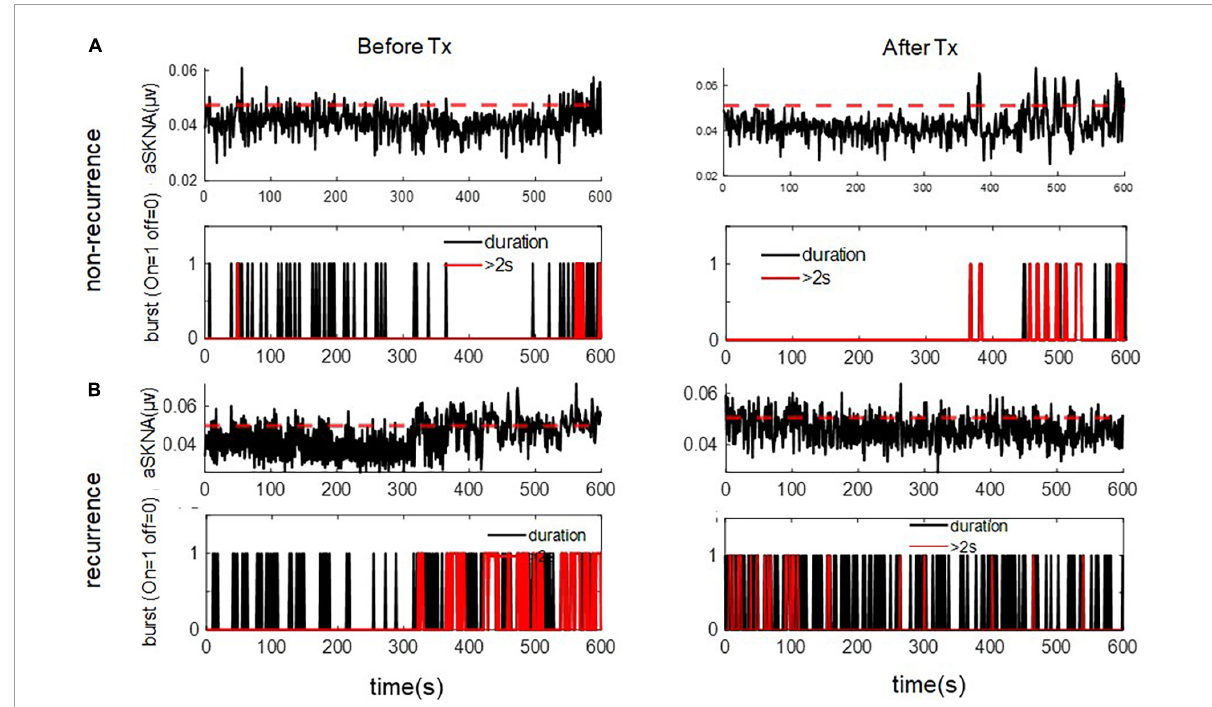
FIGURE3 The representative figure showed firing duration in a 1-s window during baseline (Before Treatment) and after ablation (After Treatment) in (A) recurred and (B) non-recurred patients. The post-ablation burst duration, esp. long duration ( > 2 s) was more frequent in the non-recurrence group. The upper panels of (A,B) represent the temporal changes of mean aSKNA (black line) and the determined threshold (red line). The lower panels of (A,B) showed the epochs with short duration of burst (black) and epochs with burst duration > 2 s (red).